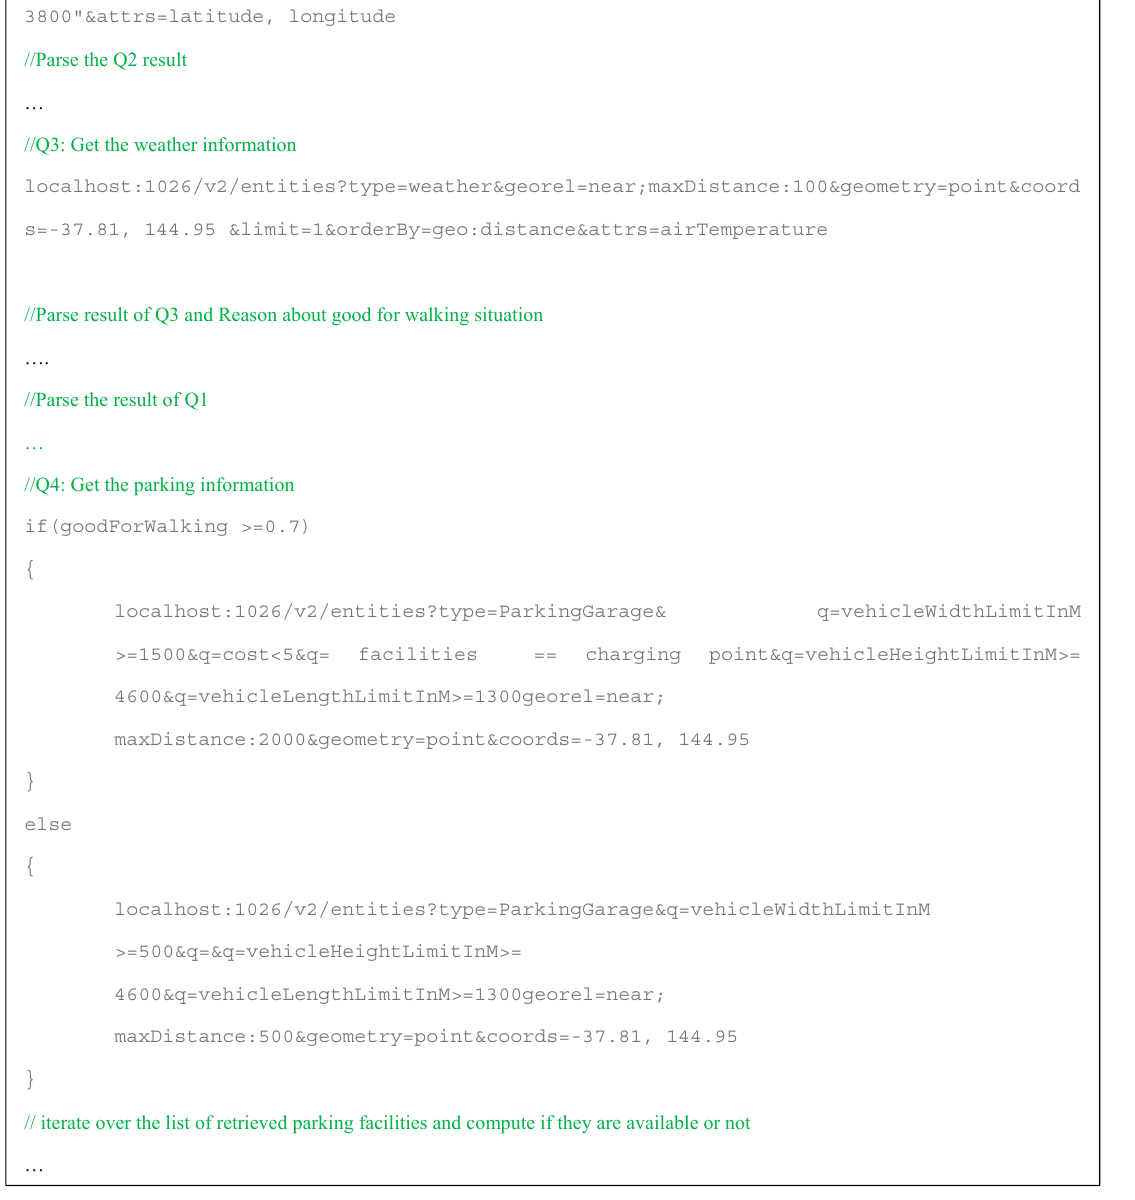
Scheme 17. NGSI queries for smart parking recommender use-case.